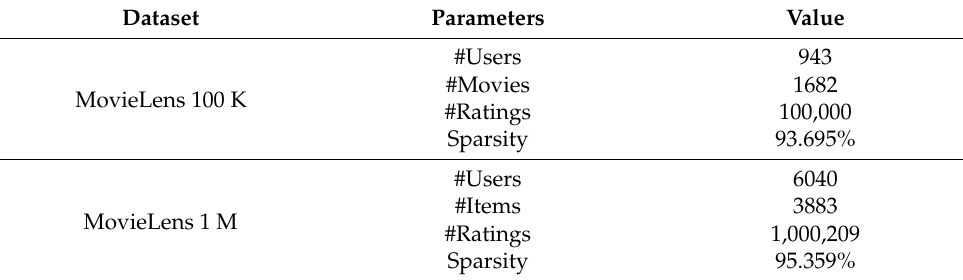
Table 1. Summary of experimental